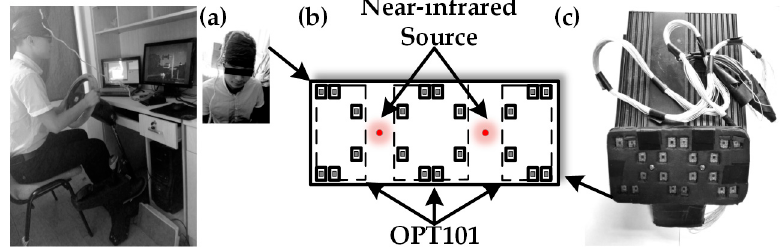
Figure 5. Fatigue evaluation: ( a ) data collection scene; ( b ) the probe for fatigue; ( c ) actual device.